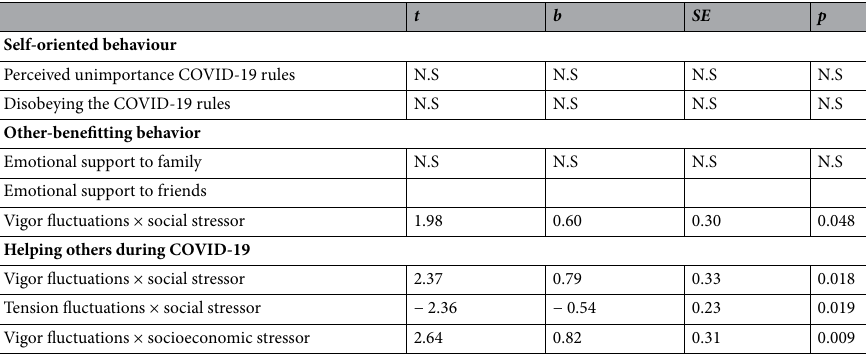
Table 2. Interaction effects between emotional reactivity and stressors on self-oriented and other-benefitting behaviors among adolescents in May 2020 (T1) that did not survive the Bonferroni correction. The social stressor is a composite score of the measures emotional maltreatment and family stress, the socioeconomic stressor is a composite score of the measures inequality of opportunity in online home schooling and financial